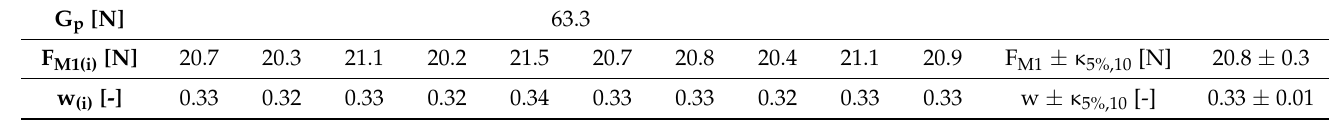
Table 1. Measured force F M1(i) [N] for the weight G p = 63.3 N acting on the conveyor belt with a length of L p = 1.65